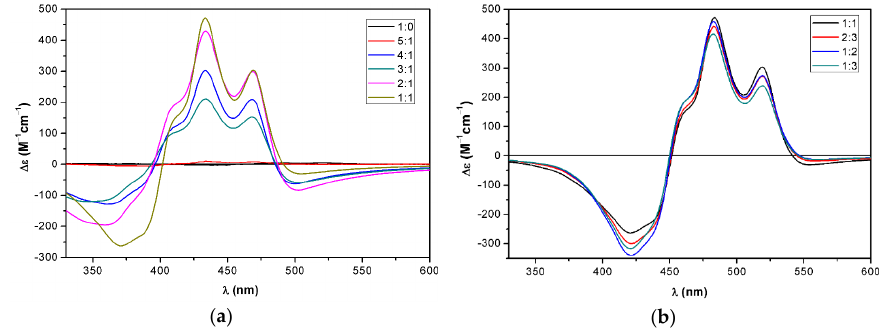
Figure 6. ECD spectra of monotriazole chrysin–zeaxanthin conjugate 23 in ( a ) acetone / water 1:0–1:1; ( b ) acetone / water 1:1–1:3.